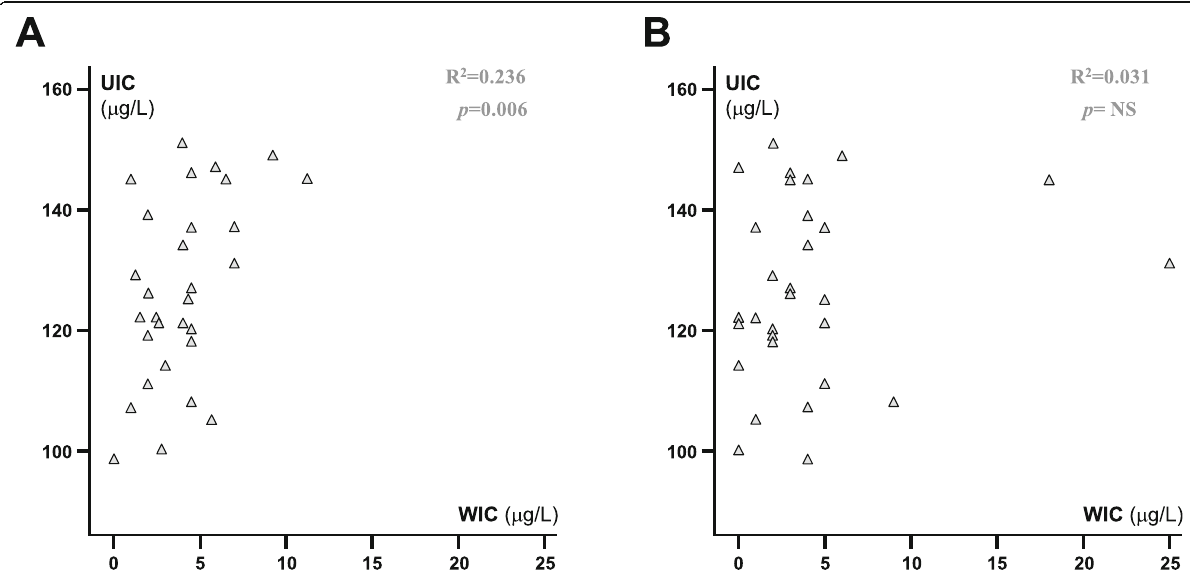
Fig. 4 Correlation between median urinary iodine concentration (UIC) from children in each of 30 schools (Fig. 2) and median water iodine concentration (WIC) from ( a ) water treatment plants in the same Swedish municipalities ( p = 0.006) and ( b ) the tap water in the same schools